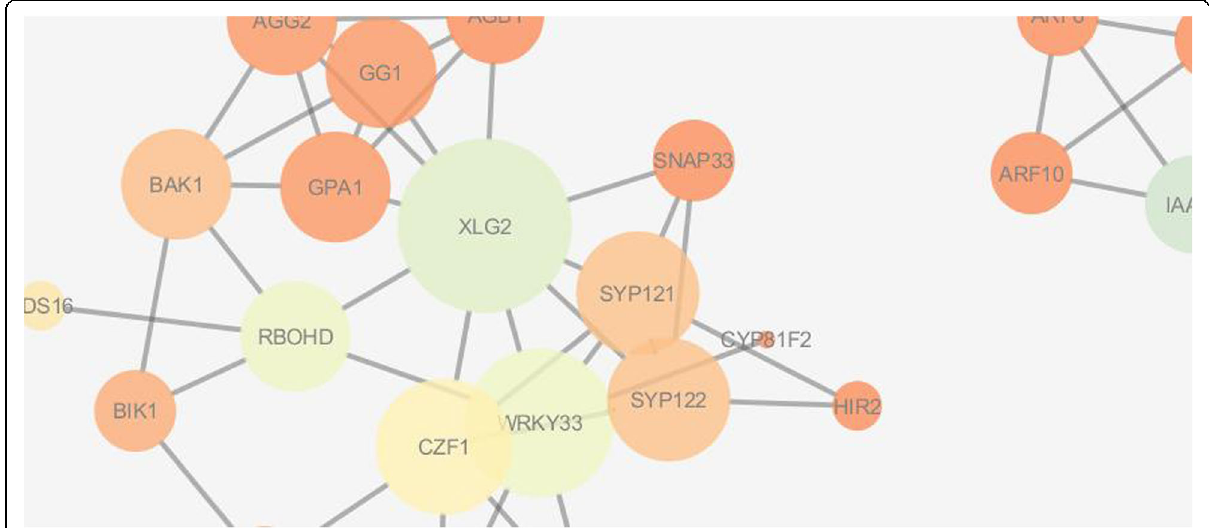
Fig. 9 Visualization of key components involved in ET -mediated resistance in Arabidopsis thaliana under contrast